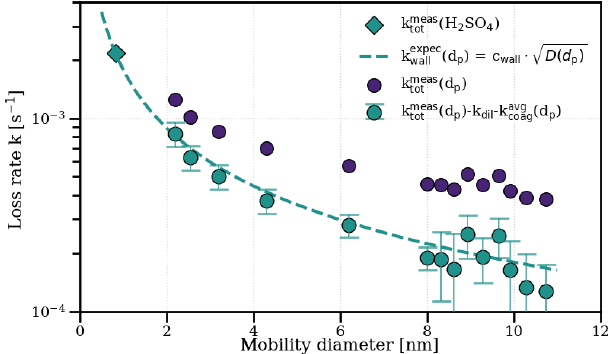
Figure 2. Measurement of zero sulfuric acid evaporation rates. The total loss rates of sulfuric acid and ammonia particles (with the mo- bility diameter shown on the x axis) were measured during a de- cay experiment (5 ◦ C, 60% relative humidity, 1000pptvNH 3 ) by switching off the UV lights after a particle growth stage, which stops the production of sulfuric acid and, subsequently, nucleation and growth. After sulfuric acid was reduced to the background level, the exponential decay rate of the remaining particles in the cham- ber was measured ( k meas tot , blue circles), which was not possible for the 1.8nm channel due to low statistics. Decay of particles in the chamber is dominated by wall loss, dilution loss and coagulation loss to other particles. Particle loss rates are corrected for an aver- aged coagulation loss during the decay ( k avg coag ) to all particles larger than d p and for the dilution loss ( k dil ; turquoise circles). They agree well with the expected wall loss rate k wall (cid:0) d p (cid:1) = C wall · (cid:112) D p (d p ) (red dashed line) with C wall = 0 . 0077s − 0 . 5 cm − 1 inferred from an independent sulfuric acid decay experiment in the absence of a par- ticle sink, where the mobility diameter is assumed to be 0.82nm (Ehrhart et al., 2016; turquoise diamond). This suggests that there is negligible evaporation from the sulfuric acid particles above ca. 2nm under the above-mentioned experimental conditions, which would introduce another term that disturbs the balance equation at each size. As all of our growth rate measurements, independent of the ammonia concentration and temperature, fall on the same line (see Fig. 1), this also points towards negligible evaporation effects at reduced ammonia levels (below 10pptv) and up to 20 ◦